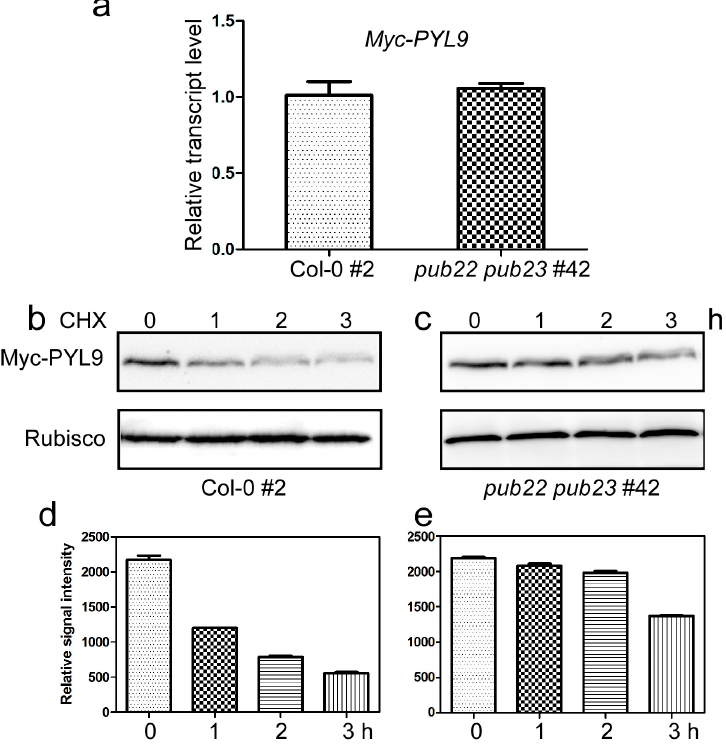
Figure 5. Myc-PYL9 is stabilized in the pub22 pub23 double mutant. ( a ) The transcript level of Myc-PYL9 in the transgenic plants in Col-0 (#2) or pub22 pub23 (#42) background. Data are the means ± standard errors ( n = 4). ( b , c ) Degradation rate of Myc-PYL9 in Col-0 ( b ); and the pub22 pub23 double mutant ( c ). Ten-day-old transgenic seedlings were incubated in liquid MS medium containing 50 µ M MG132 for 16 h and washed five times before being transferred to liquid medium with 100 µ M cycloheximide (CHX). Proteins were isolated at the indicated time points and detected with anti-Myc antibody. Anti-Actin was used as loading control. ( d ) Quantitative evaluation of the Myc-PYL9 protein level in ( b ). ( e ) Quantitative evaluation of the Myc-PYL9 protein level in ( c ). Independent experiments were repeated three times with the similar results. Data are the means ± standard errors ( n = 3).